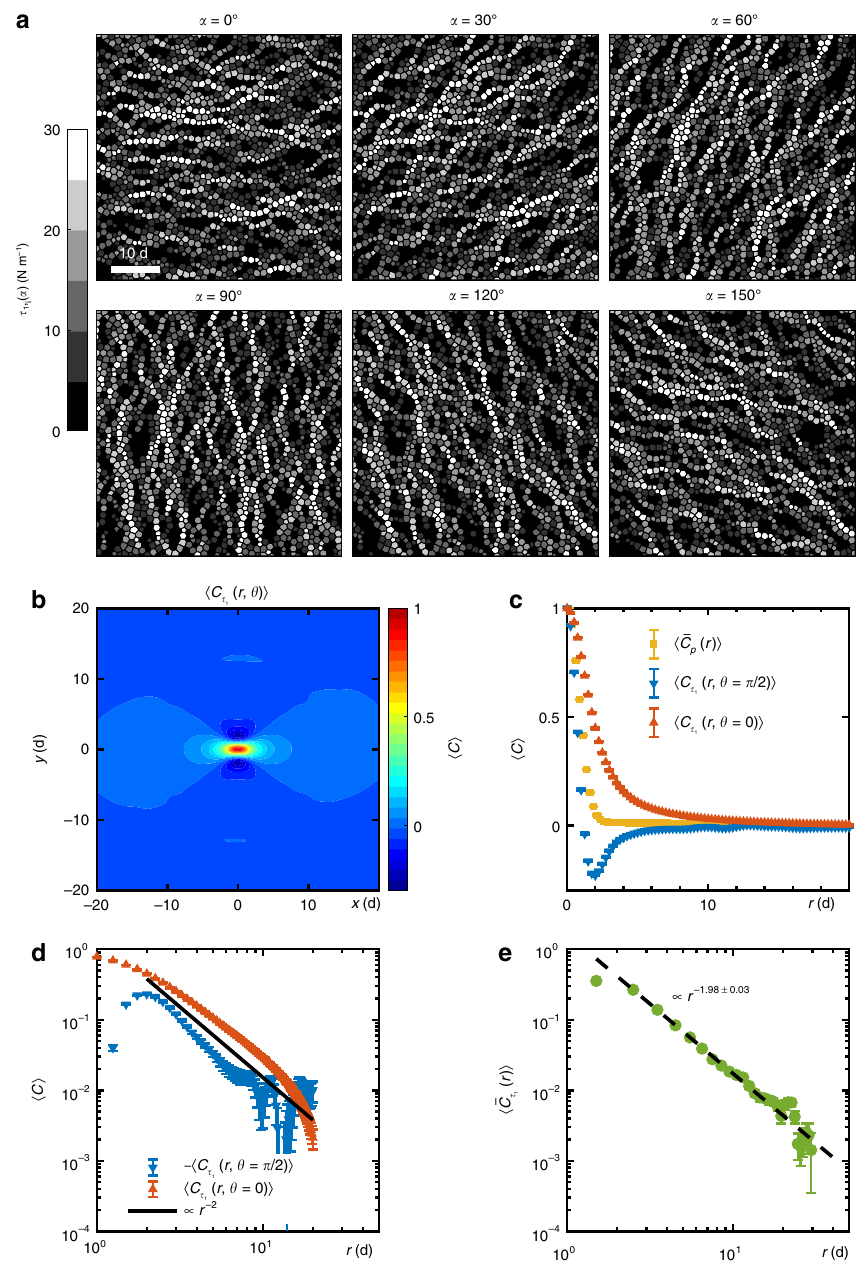
Fig. 3 Spatial distributions of polarized stress fi elds and their autocorrelation functions. a Spatial distributions of six polarized stress fi elds τ 1 ( α ). Scale ð r ; θ Þi of coarse-grained polarized stress τ α ), 〈 ⋯ 〉 denotes ensemble average over 100 con fi gurations and bar = 10d. b Spatial autocorrelation map h C τ 1 ( 1 ð r ; θ Þi along θ = 0, π /2 and autocorrelation function of coarse-grained different polarized angles α . Here, 〈 C 〉 denotes correlation functions. c Cuts of h C τ 1 ð r ; θ ¼ 0 Þi and (cid:2)h C ð r ; θ ¼ π = 2 Þi . The solid line ∝ r − 2 is guide to the eye. pressure h (cid:1) C p ð r Þi , the over bar denotes average over θ . d Log-log plots of h C τ τ 1 1 ð r Þi . The error bars represent the standard errors. The black dashed line indicates a power law e The azimuthal averaged autocorrelation function of τ 1 , h (cid:1) C τ 1 fi t of h (cid:1) C ð r Þi for r > τ 1